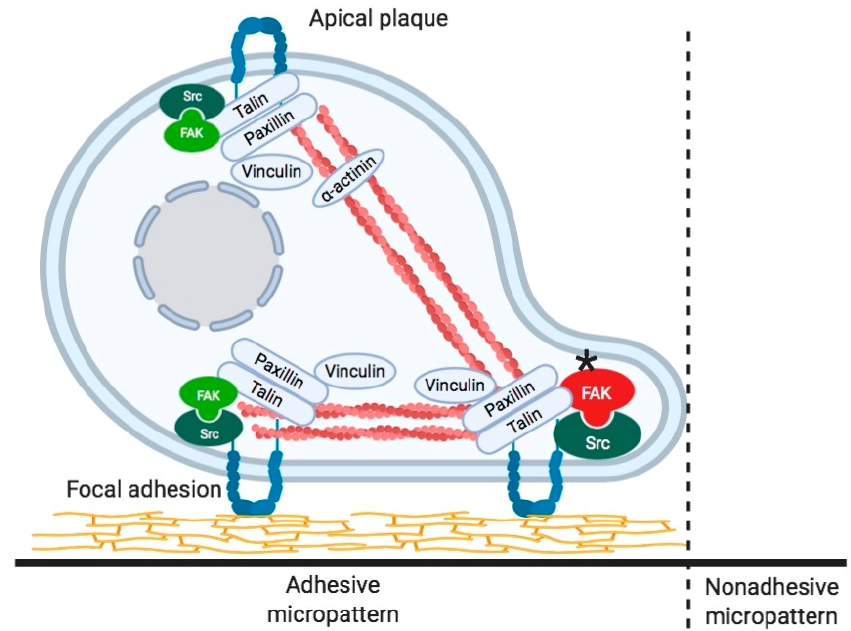
Figure 3. Schematic illustration of a cell adherent on the border of the adhesive and nonadhesive micropatterns. Focal adhesions at the bottom of the cells and the apical plaque are shown. Focal adhesion kinase (FAK) is highly accumulated at the border between adhesive and nonadhesive micropatterns, and the FAK seems to be tyrosine phosphorylated. The asterisk indicates tyrosine phosphorylated active FAK.